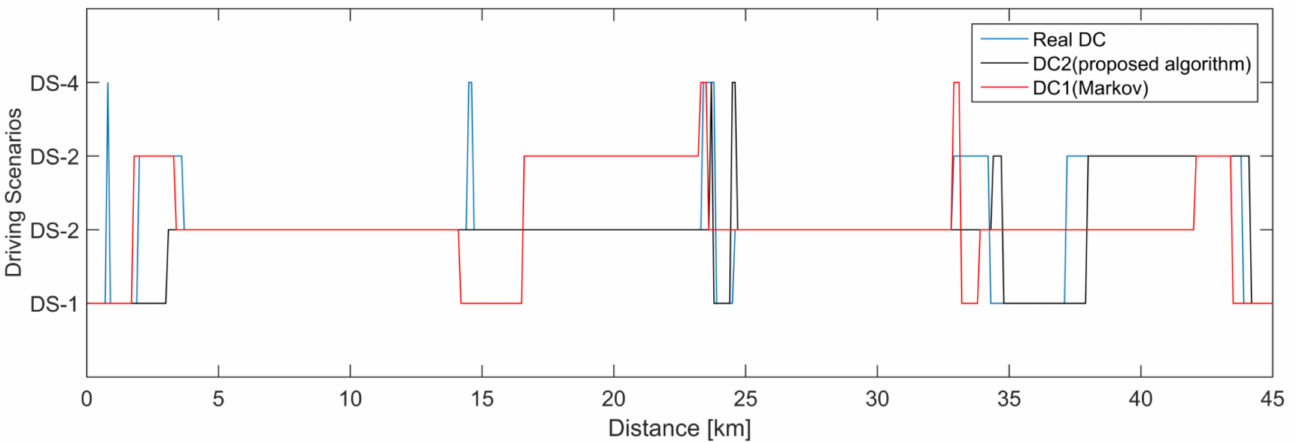
Figure 19. Driving scenario labels (real DC, DC-1, and DC-2).